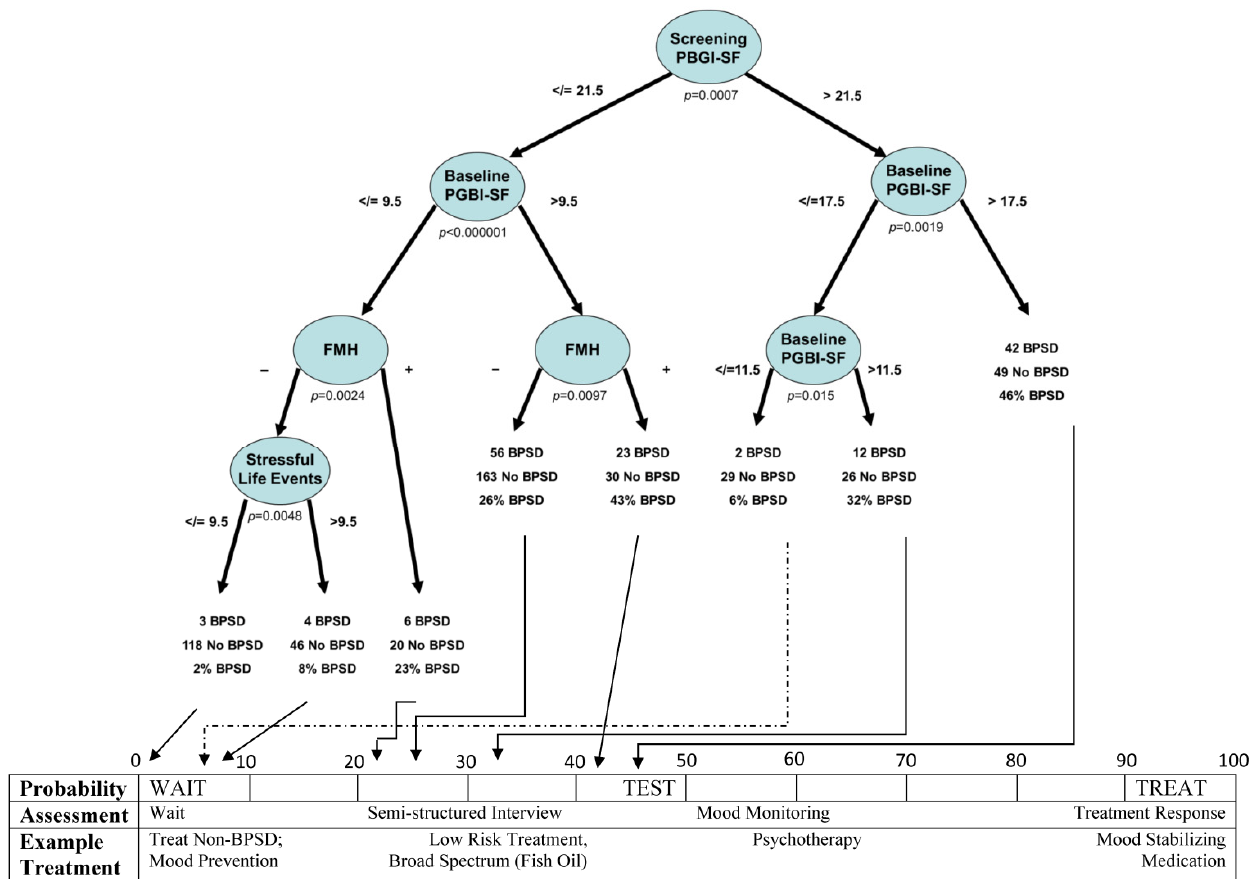
Figure 1. Classification tree analysis decision tree predicting the presence vs . absence of a Bipolar Spectrum Disorder